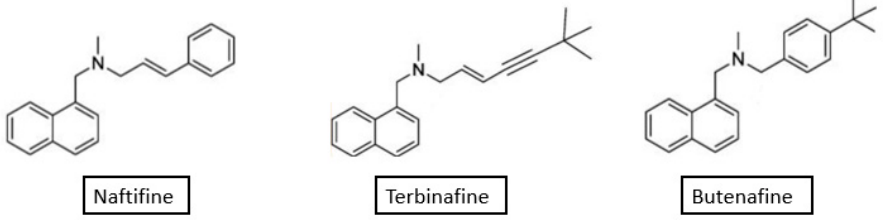
Figure 1. Chemical structures of naftifine, terbinafine, and butenafine. Structures were retrieved from data deposited in or computed by PubChem (https://pubchem.ncbi.nlm.nih.gov, accessed on 10 November 2022).